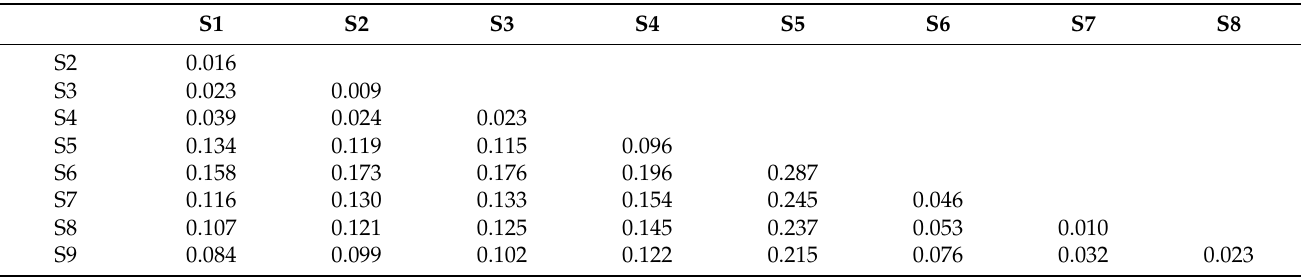
Table 3. Jeffries–Matusita Distance (JMD) Values of Wavelengths in Tree Species.